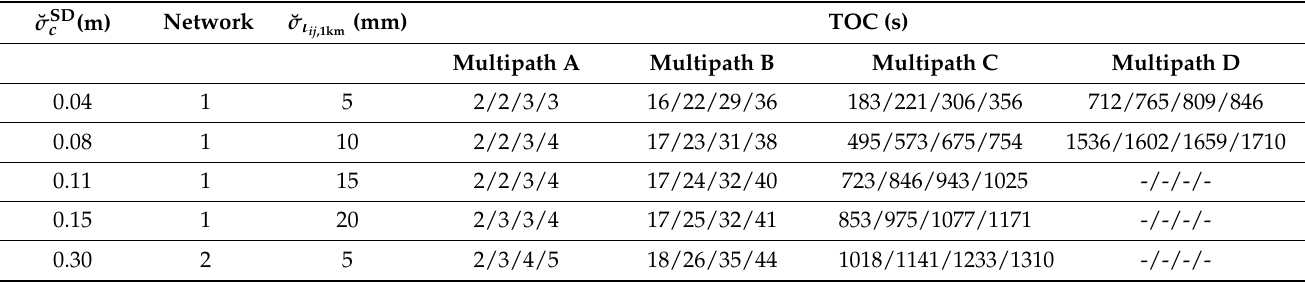
Table 8. Time-to-convergence (TOC) to 1.5 m for ambiguity-float HPLs for multipath scenarios A–D. Under each multipath scenario, the TOC for PMI H of 2 × 10 − 3 , 2 × 10 − 4 , 2 × 10 − 5 and 2 × 10 − 6 are separated by “/”. “-” represents the case when convergence is not reached until 30